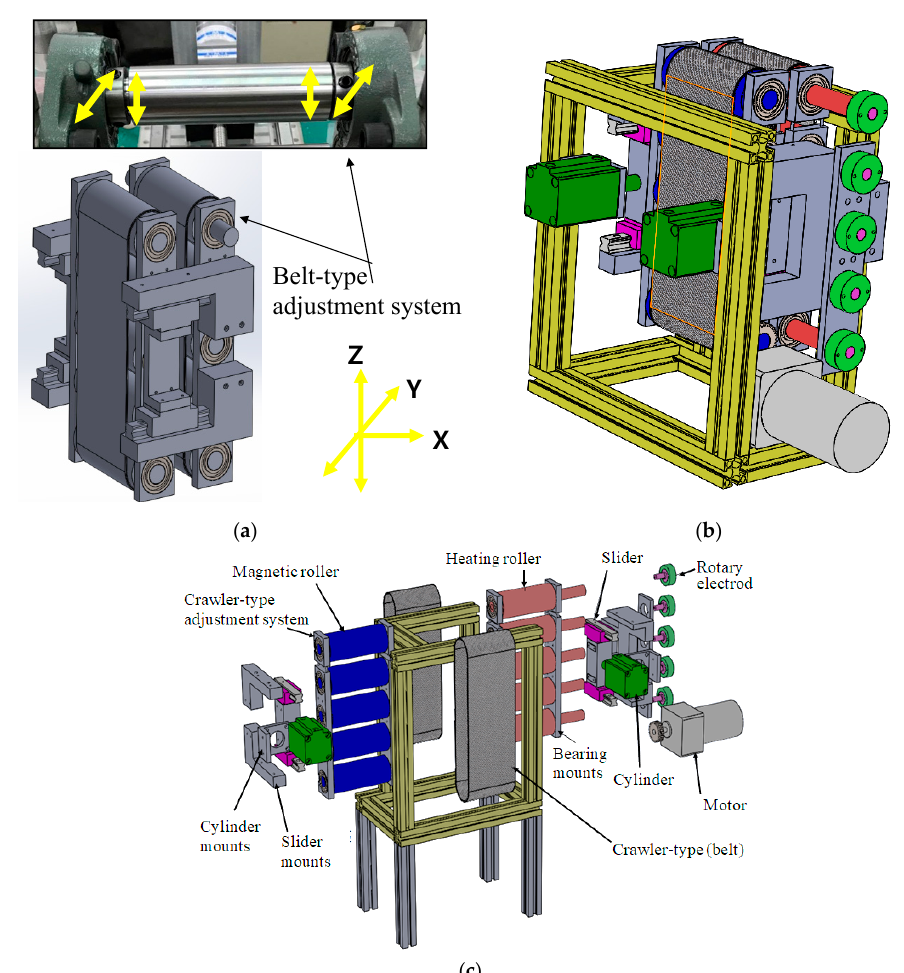
Figure 2. Schematic diagram of belt-type micro hot rolling system ( a ) belt assembly testing schematic diagram, ( b ) stereo isometric view, and ( c ) exploded view and spare parts list.